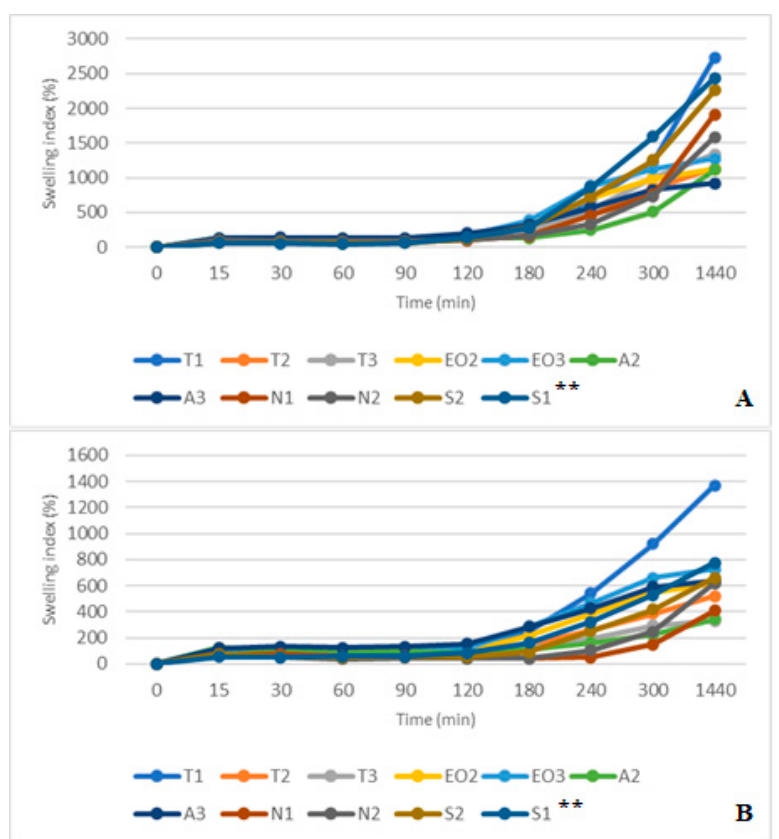
Figure 13. (A ) NEO-loaded calcium alginate microcapsules swelling in SGF and SIF media. ( B ) NEO- loaded calcium alginate microcapsules swelling in SGF+ pepsin and SIF+ pancreatin media. ** The code is given in Table 1, n =